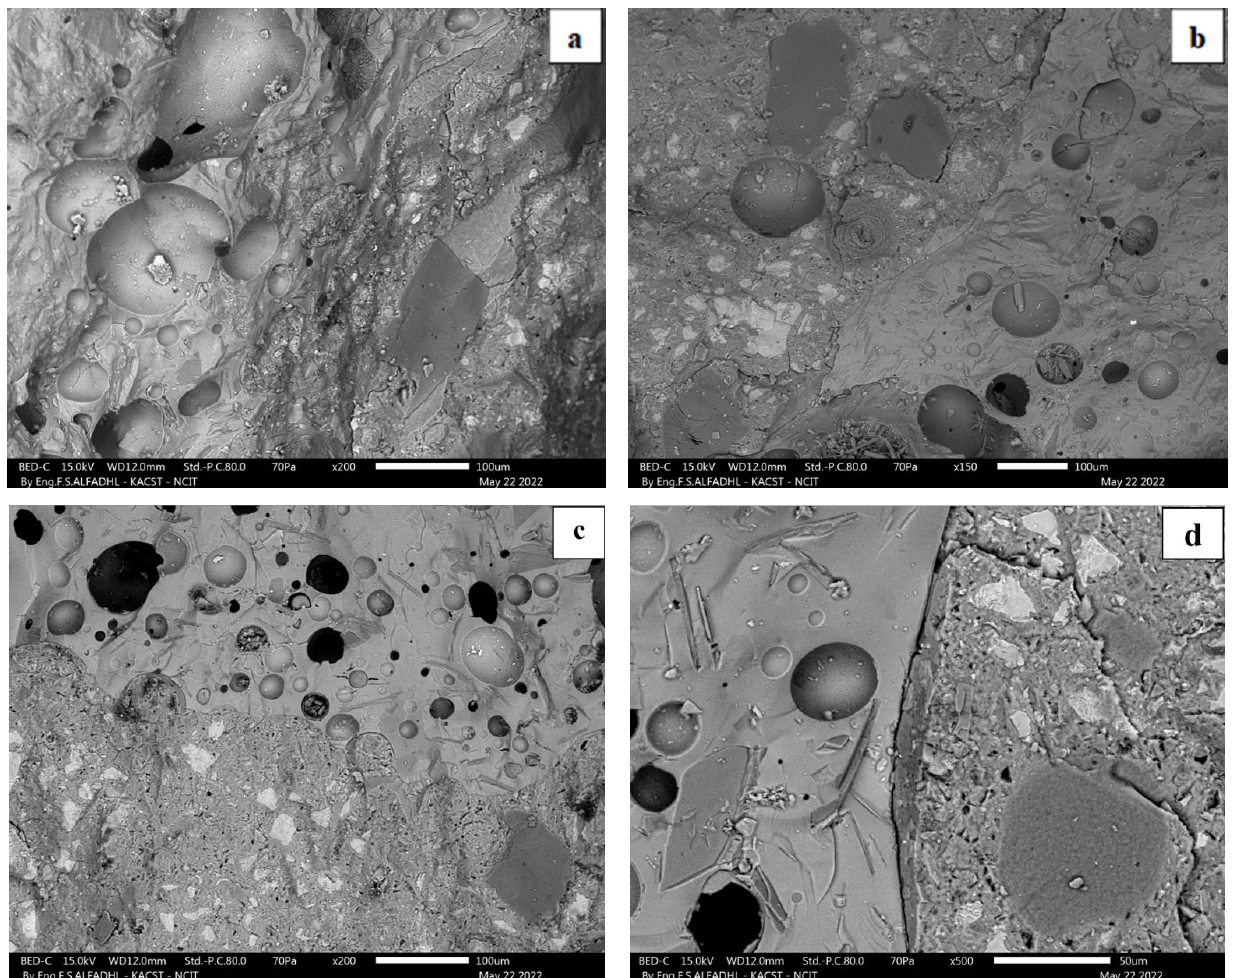
Figure 8. Microstructural SEM images of UHPC-L15: ( a ) ambient at 200× magnification; ( b ) ambient at 150× magnification; ( c ) 200 °C at 200× magnification; and ( d ) 200 °C at 500× magnification.